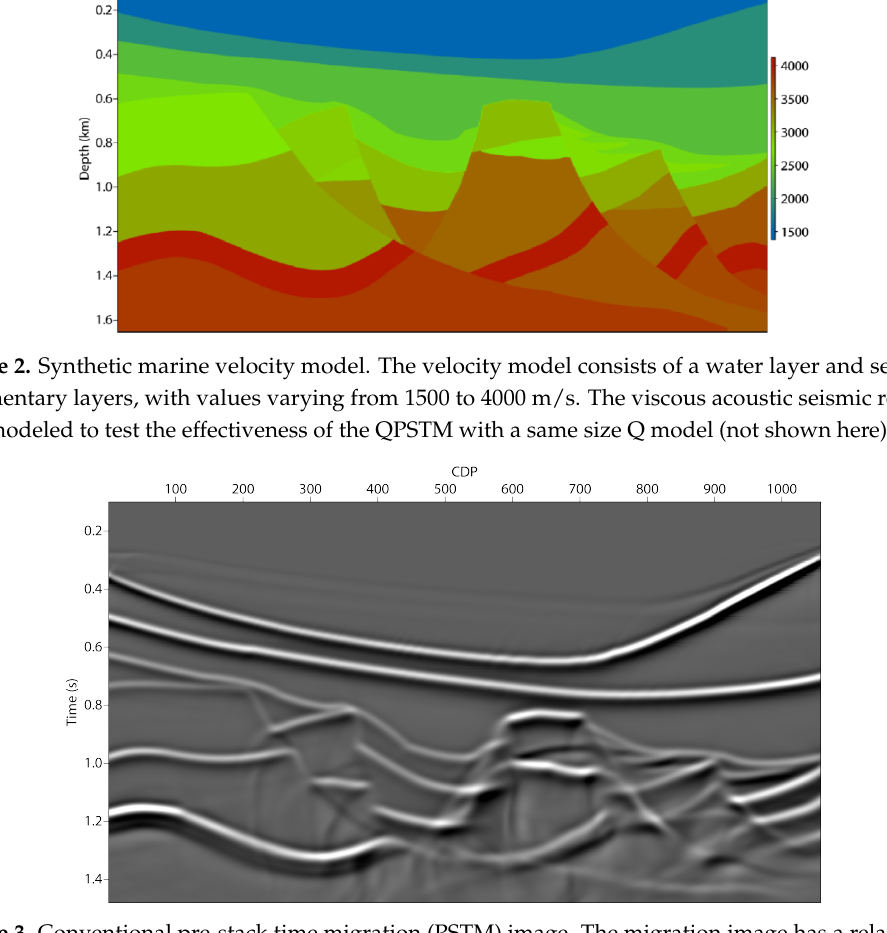
Figure 3. Conventional pre-stack time migration (PSTM) image. The migration image has a relatively lower resolution owing to the energy attenuation and phase